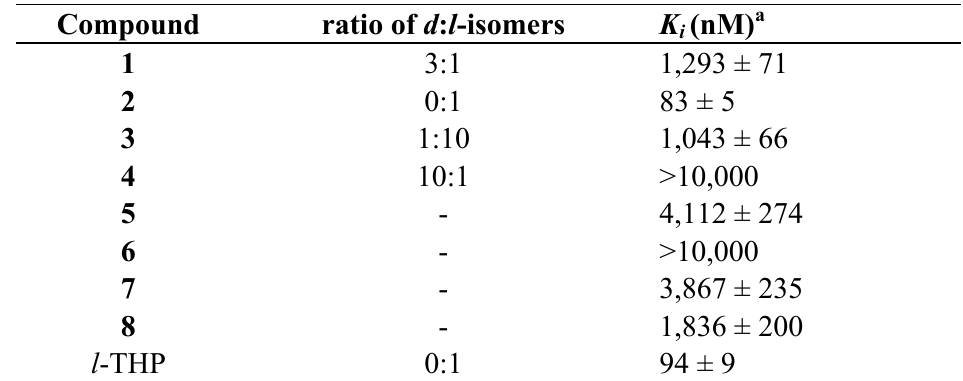
Table 2. Binding affinities of the purified alkaloids for the [ 3 H] SCH 23390 labeled the hD R in transiently transfected HEK-T 1